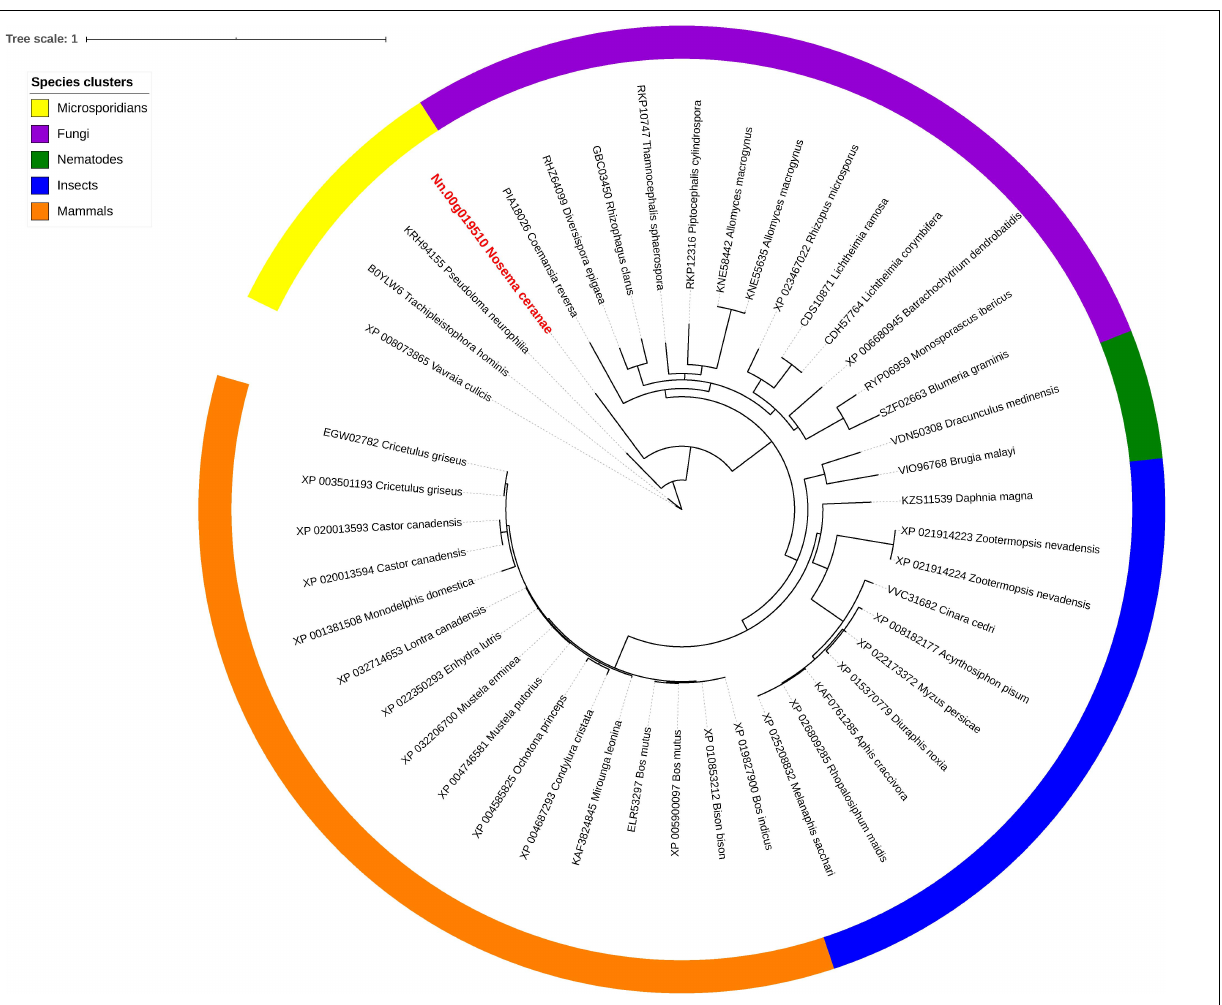
FIGURE 6 | Maximum likelihood phylogenetic tree of Nfs1 proteins. Branches are labeled as GenBank accession numbers followed by species names. Branches with bootstrap values (1,000 replicates) less than 0.5 were discarded. The genetic distance is drawn to scale. The current Nosema ceranae record is highlighted with red color. The definitions of the species clusters are adopted from NCBI Taxonomy